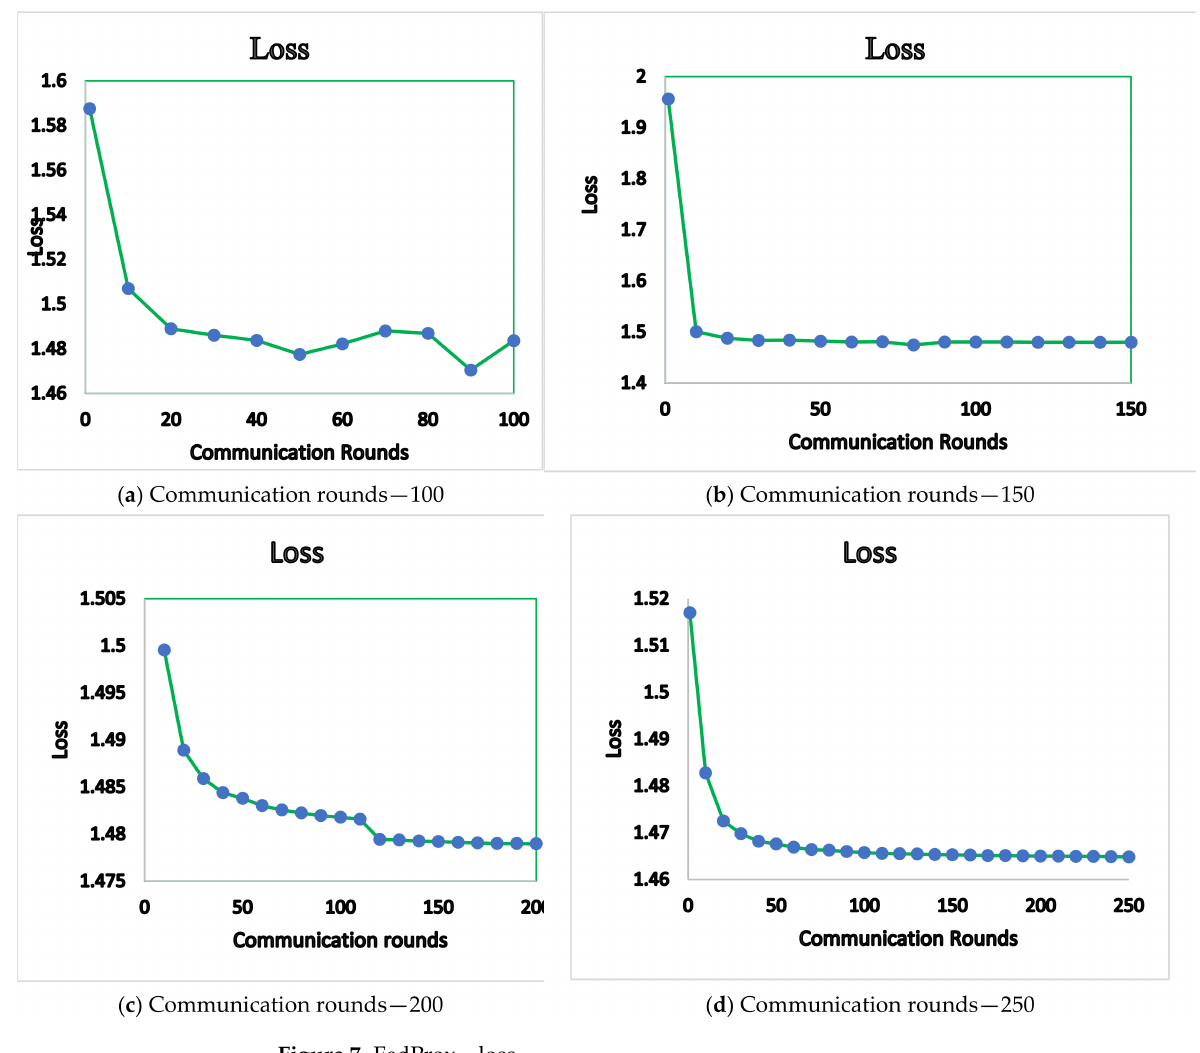
Figure 7. FedProx—loss.